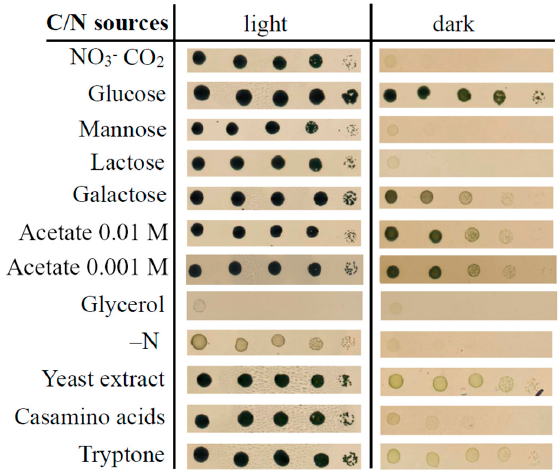
Figure 9. Growth of Neochlorella semenenkoi IPPAS C-1210 in modified BG-11 media with 20mM HEPES (pH 7.5) and different N sources. The error bars show standard deviations of the mean ( n = 3). The variants with the same letter are not significantly different (one-way ANOVA analysis, post hoc Tukey HSD test; p < 0.05).